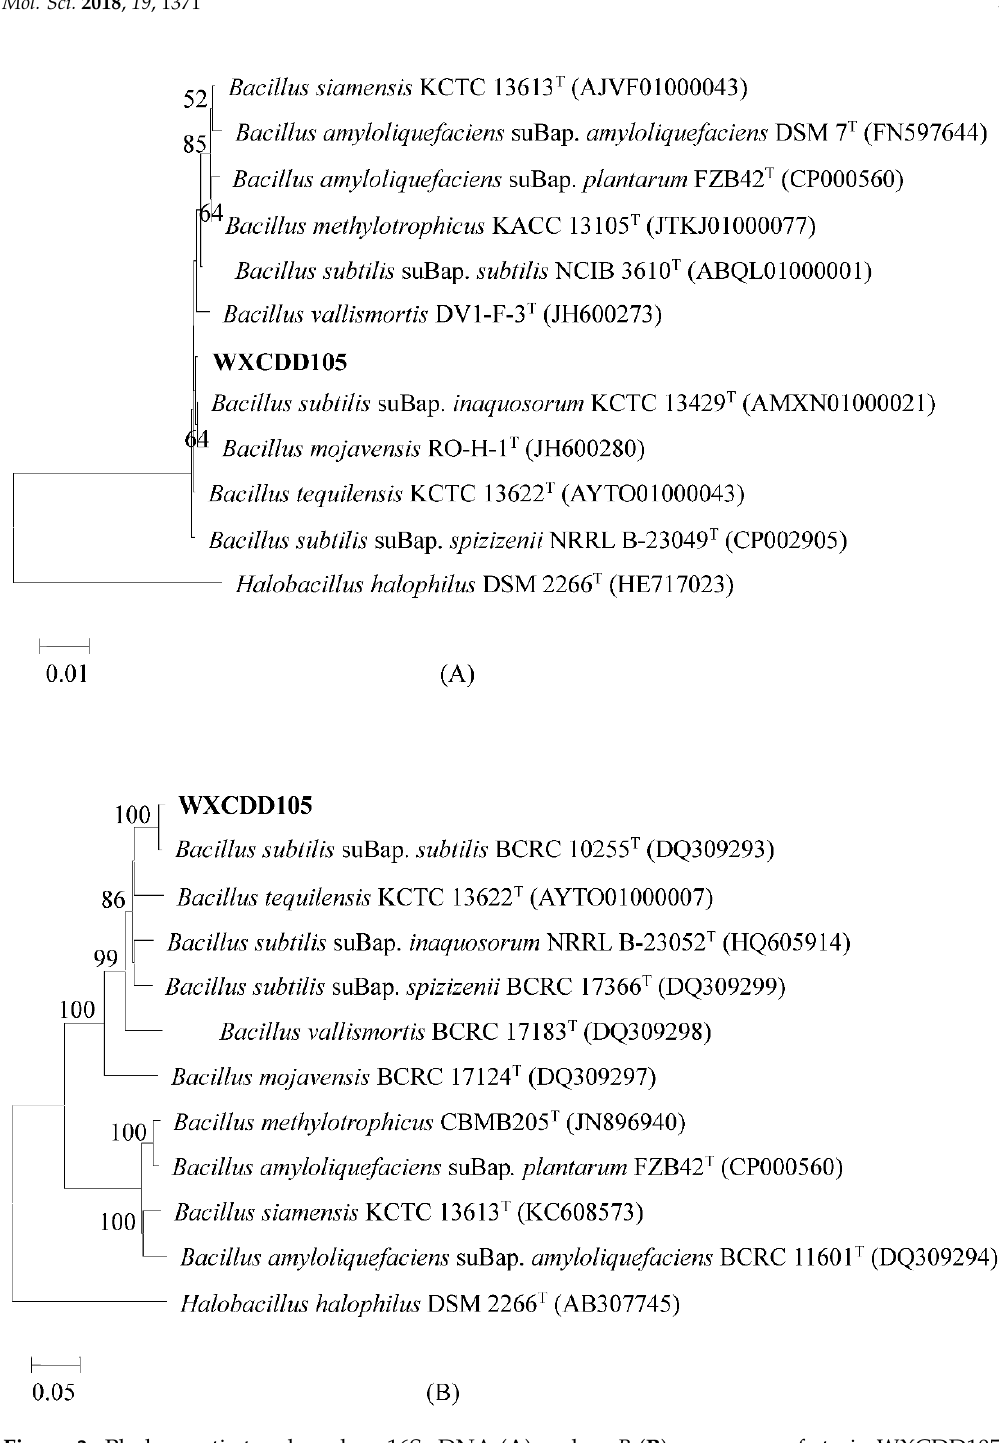
Figure 3. Phylogenetic tree based on 16S rDNA ( A ) and gyrB ( B ) sequences of strain WXCDD105. The nodes of the phylogenetic tree where the value of bootstrap is greater than 50%, which will be noted in the graph, and the superscript “T” indicates the model strain.